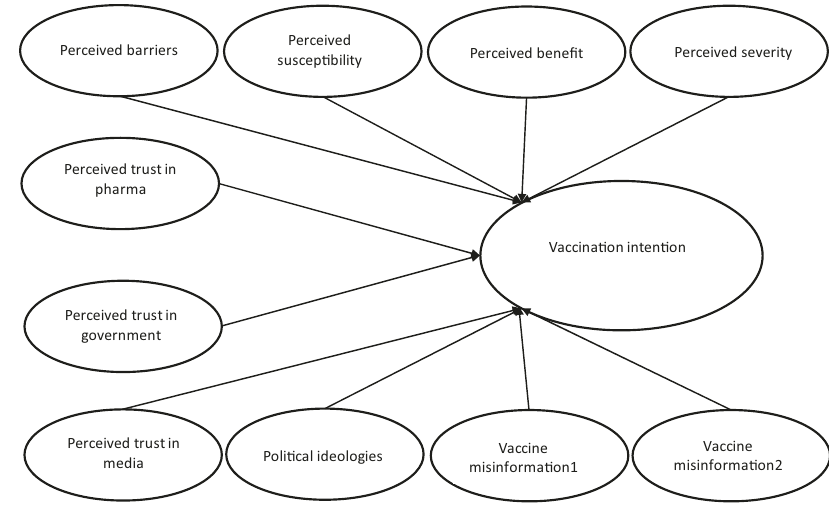
Fig. 3 Research model. The proposed research model with several independent variables and one dependent